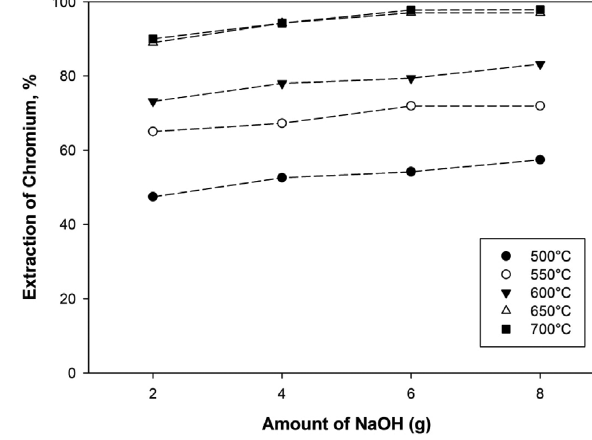
Fig. 5: The effect of temperature on the conversion percentage of chromium (1 hour, 1 g